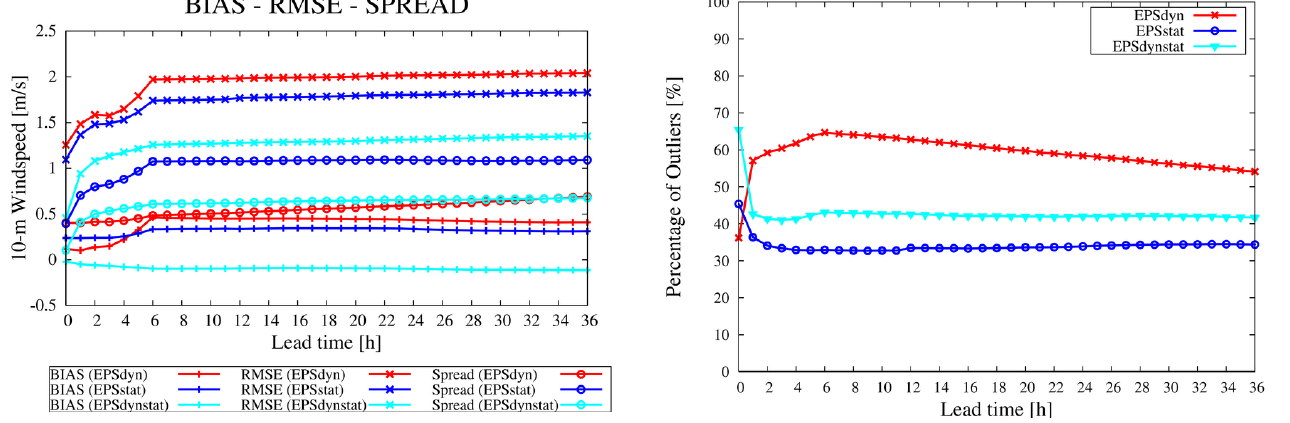
Figure 4. Percentage of outliers as a function of lead time, for the dynamical (red), statistical (dark blue) and dynamic-statistical (light blue) approach.